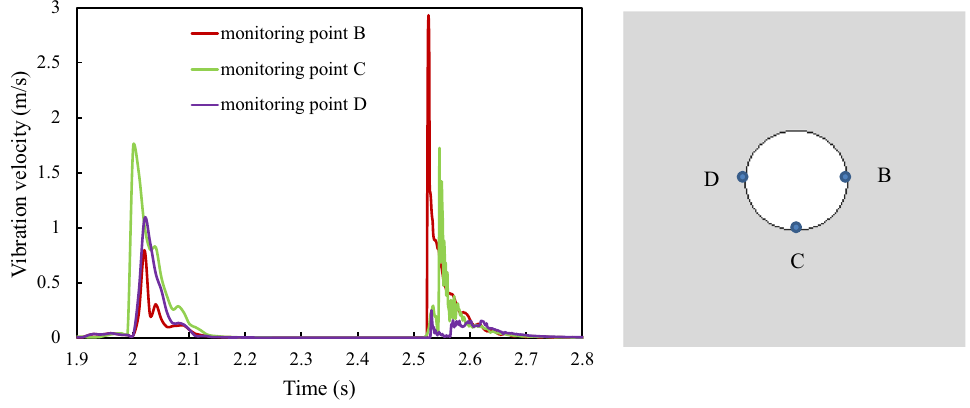
Fig. 12 Vibration velocity–time evolution curves for three monitoring points in different locations of cavern (dynamic disturbances in horizontal